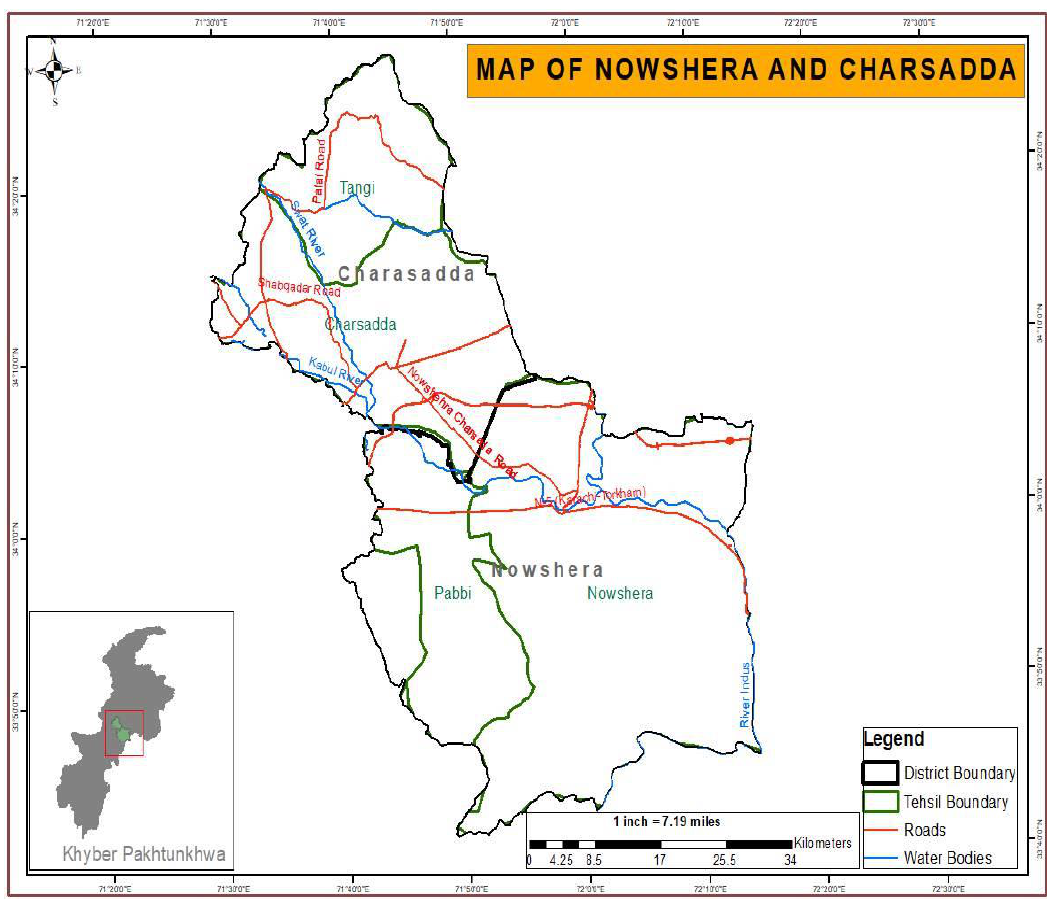
Figure 1. Study area